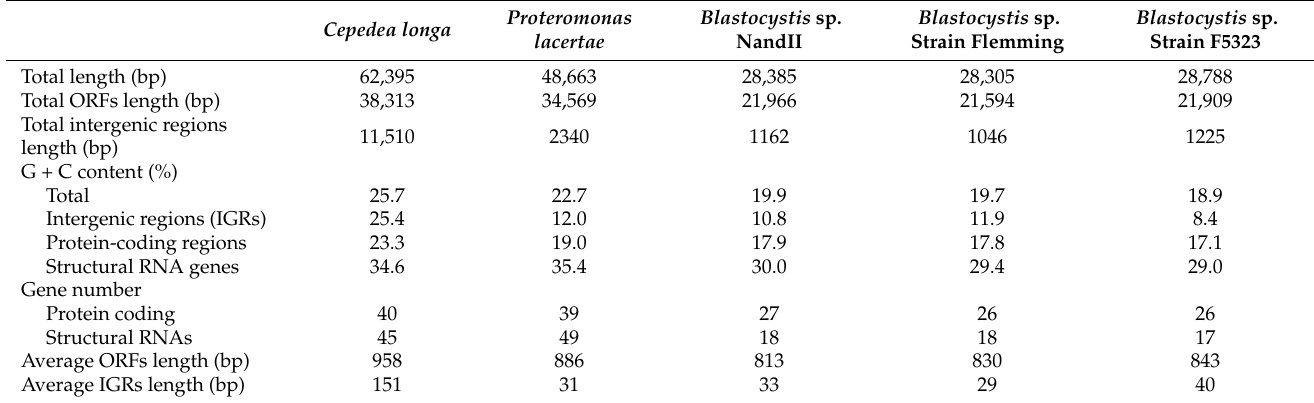
Table 1. Comparison of characteristics of MRO genomes of Cepedea longa and other Opalinata species. Proteromonas Blastocystis sp. Blastocystis sp. Cepedea longa lacertae NandII Strain Flemming